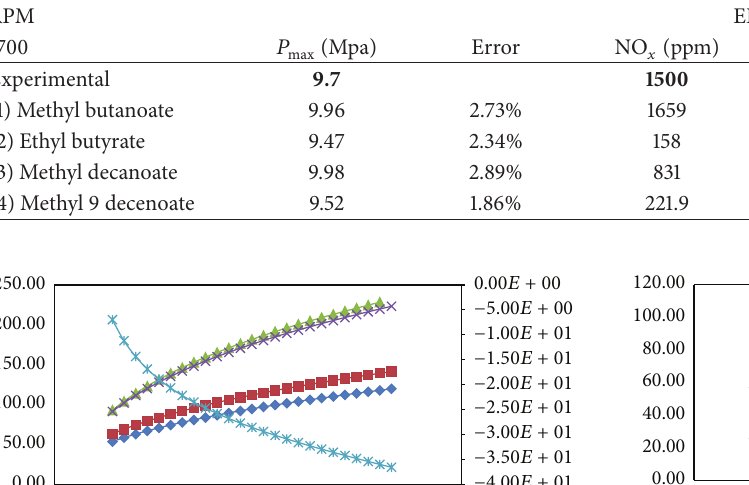
Table 9: Comparative experimental and simulated results for ethyl ester biodiesel and each surrogate at 1700rpm.